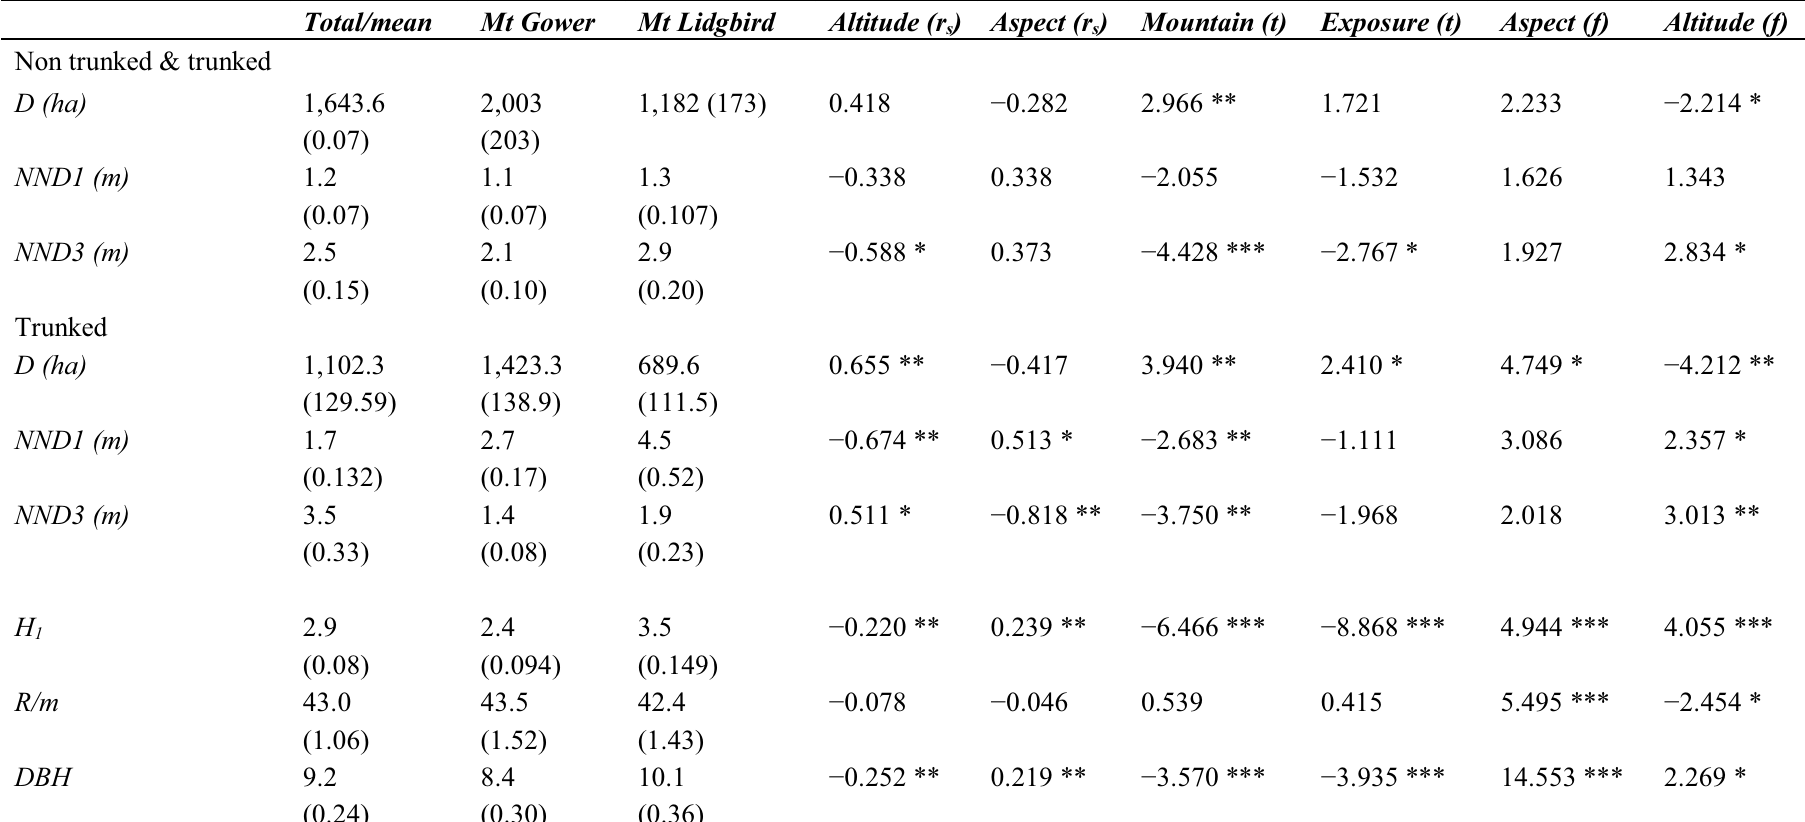
Table 2. Summary of H. canterburyana population density and growth characteristics, Mt Gower and Mt Lidgbird means and statistical results for factors that may contribute to variation. Number of individuals surveyed ( n ) = 760. Density of the site ( D ), average distance to one ), number of leaf scars per metre ( R/m ), diameter at breast height ( DBH ). and three nearest neighbours ( NND1 , NND3 ), average height ( H 1 ); results of Independent T-tests ( t ) for the Standard errors in parenthesis Results of Spearman (cid:182) s rank correlation for altitude and aspect ( r s effects of mountain, exposure and altitude; ANOVA ( f ) between populations at different cardinal aspects. For all tests * p < 0.05, ** p < 0.01, *** p <